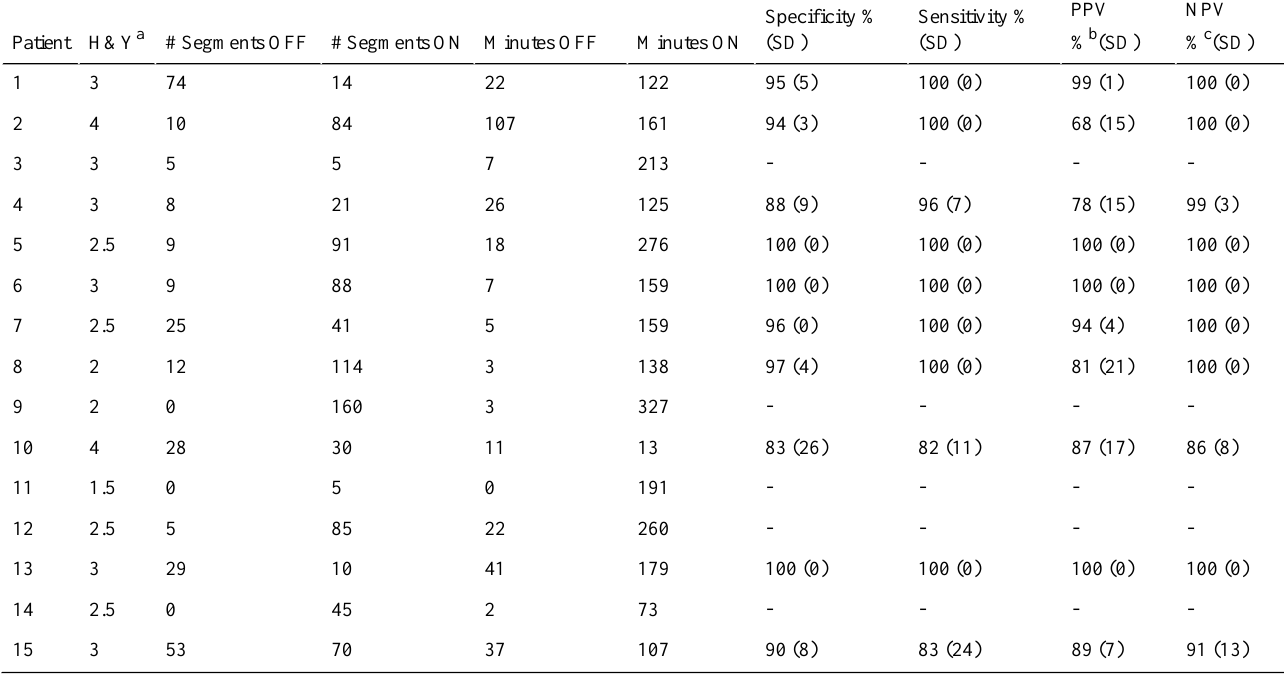
Table 2. Algorithm applied to walking segments of 10 or more strides.